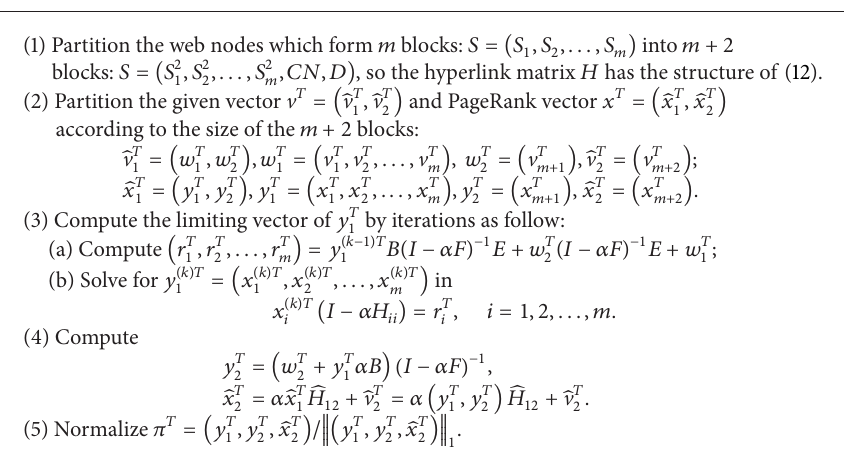
Algorithm 2: An algorithm based on a separation of the common